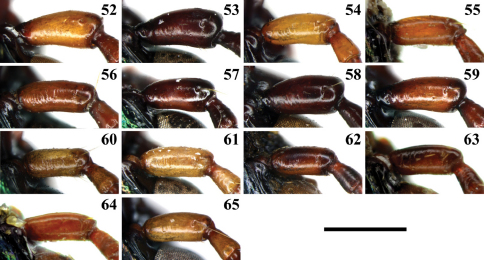
Antennomere 1 of Chlaenius (Lithochlaenius) species52 Chlaenius chuanqianensis sp. n., holotype53 Chlaenius linwensini sp. n., holotype54 Chlaenius propeagilis sp. n., holotype55 Chlaenius agilis Chaudoir, holotype56 Chlaenius formosensis Lorenz, CCCC57 Chlaenius leishanensis Kirschenhofer, IZCAS58 Chlaenius noguchii Bates, IZCAS59 Chlaenius wrasei Kirschenhofer, IZCAS60 Chlaenius agiloides Jedlička, IZCAS61 Chlaenius rambouseki Lutshnik from Ussuri region, IZCAS62 Chlaenius anchomenoides Bates, paratype63 Chlaenius nuristanus Jedlička, paratype64 Chlaenius nuristanus a. rubridipes Jedlička, paratype65 Chlaenius rambouseki Lutshnik from Taiwan,CCCC. Scale line = 1.0 mm.